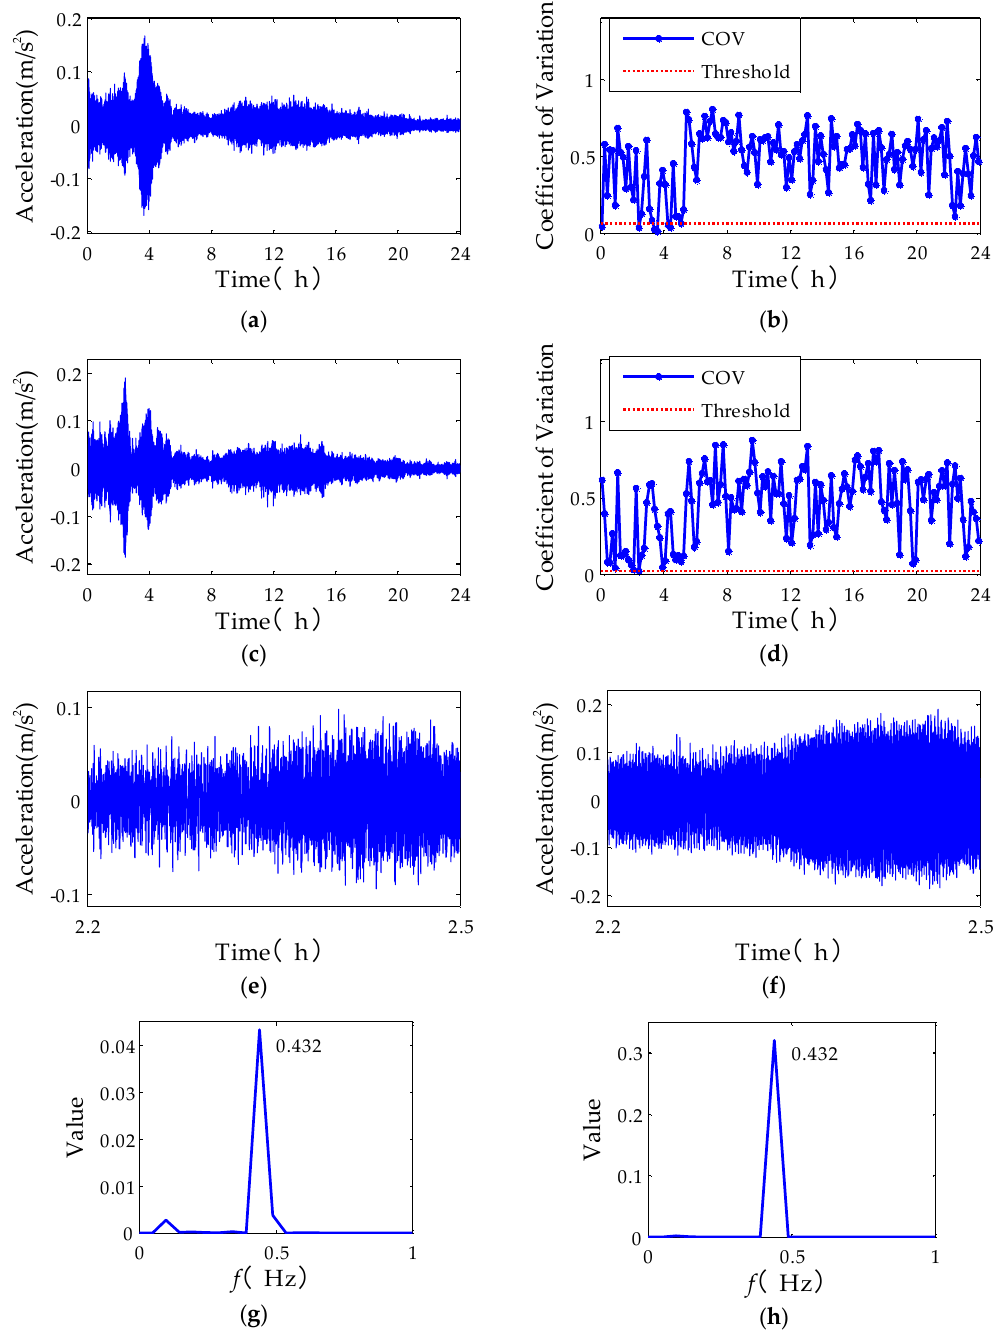
Figure 22. The random decrement signal and power spectrum of the eighth mode VIV on 25 May 2015: ( a ) Acceleration at quarter span; ( b ) COV and threshold at quarter span; ( c ) acceleration at half span; ( d ) COV and threshold at half span; ( e ) the identified VIV signal at quarter span; ( f ) the identified VIV signal at half span; ( g ) PSD of VIV data at quarter span; ( h ) PSD of VIV data at half span.